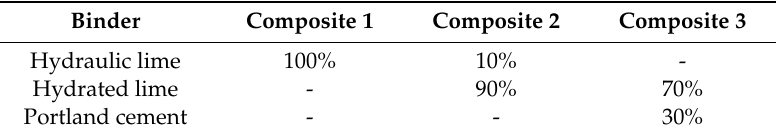
Table 1. Composite mixtures used for testing.